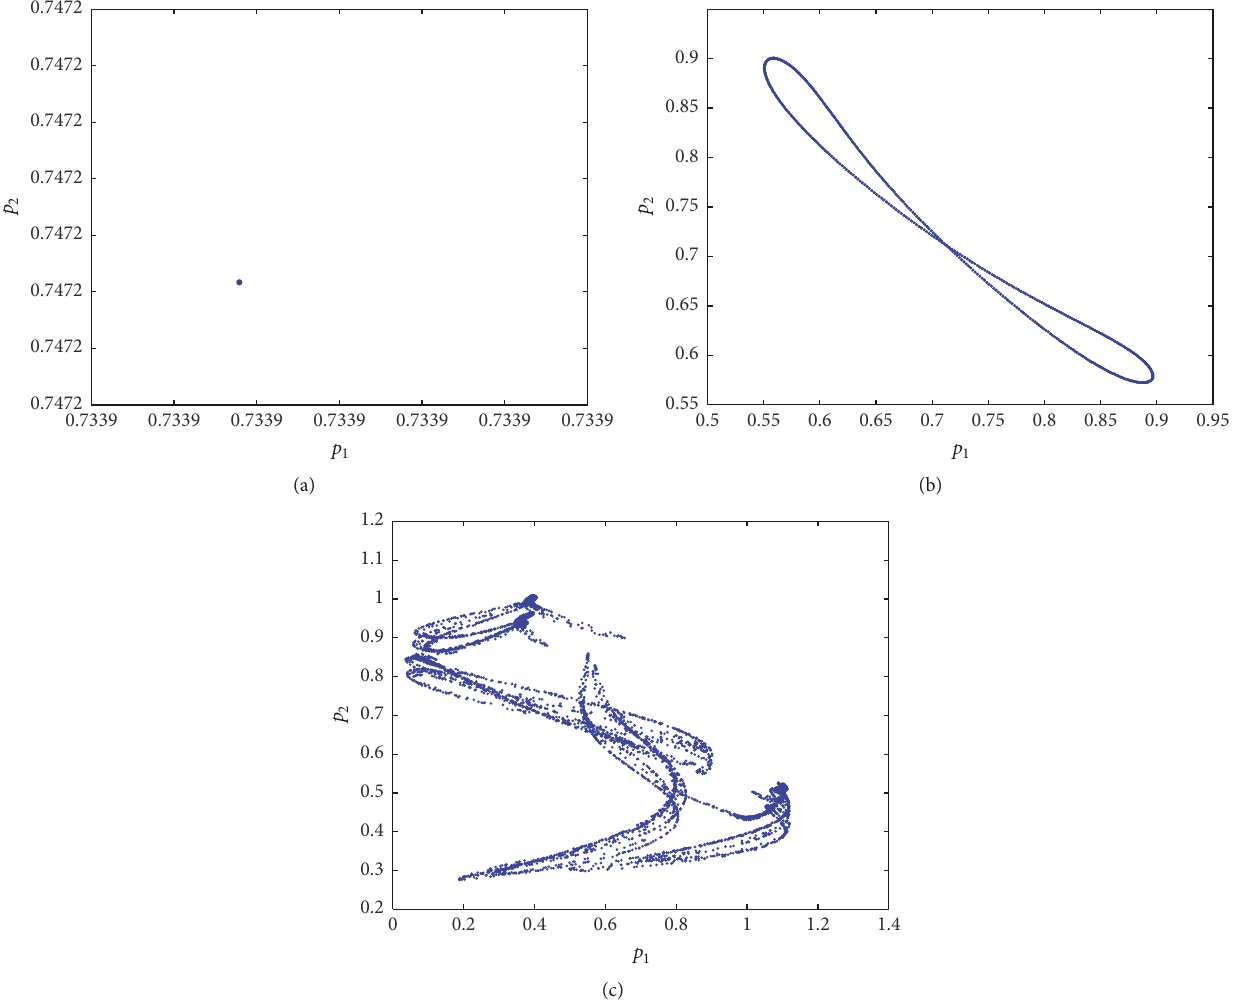
Figure 3: Attractor when 𝜃 = 0.5 , 𝛼 = 0.5 , 𝑤 𝑖 = 0.5 , and 𝛼 2 = 0.25 : (a) 𝛼 1 = 0.2 , (b) 𝛼 1 = 0.25 , and (c) 𝛼 1 = 0.32 .